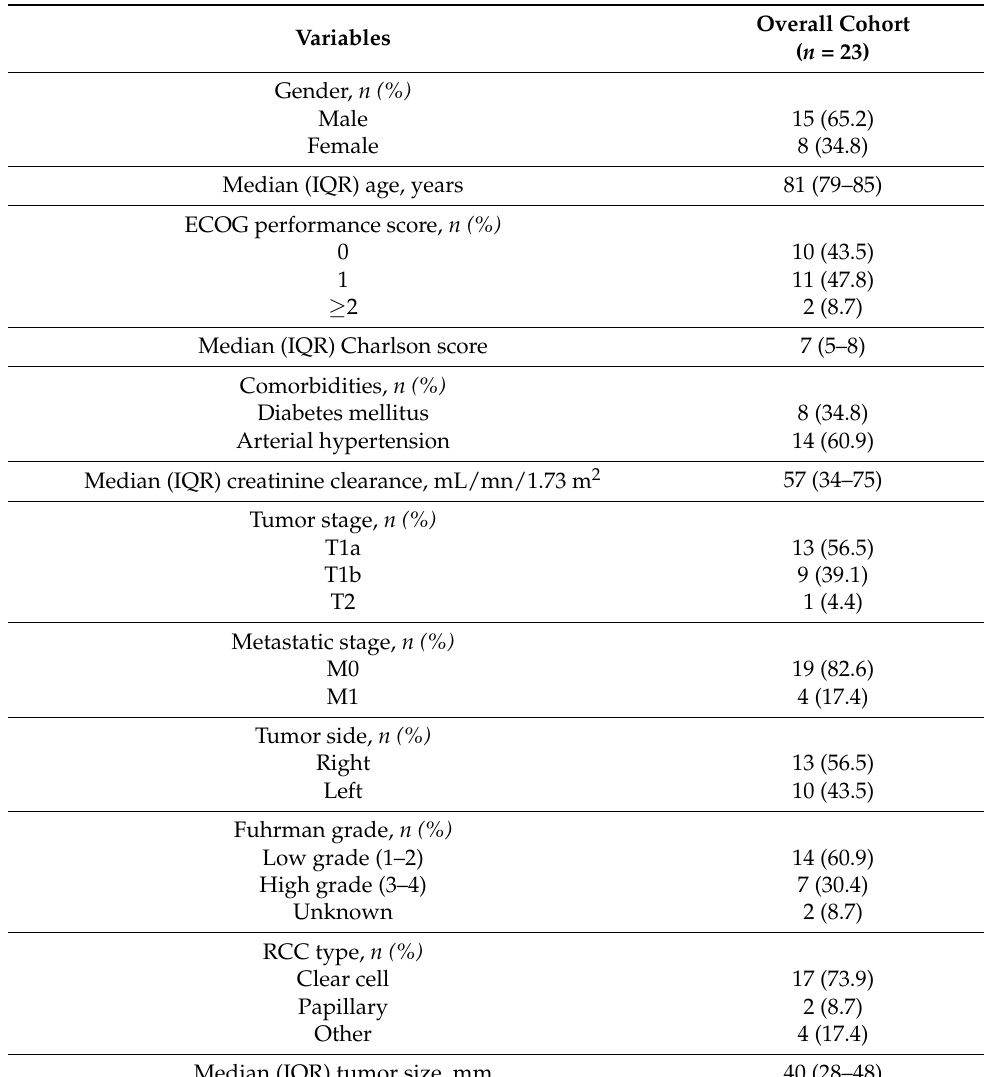
Table 1. Baseline characteristics.